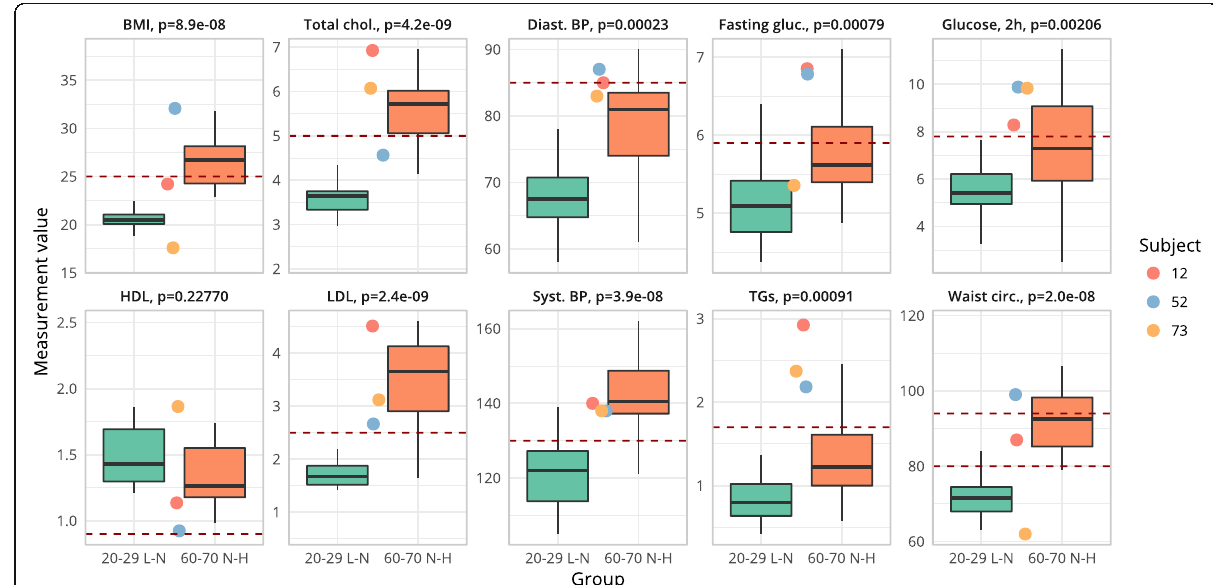
Fig. 2 Boxplots for the two reference groups “ optimal phenotypic flexibility ” (green) and “ reduced phenotypic flexibility ” (red) as well as the values of the three outlier subjects (subjects 12, 52, and 73 shown in a red, blue, and yellow circle, respectively). Box shows the 25 to 75% interquartile range; whiskers indicate the maximum and minimum non-outlier values. Crossbar indicates the median values. Horizontal dotted line indicates cut-off values; levels above this line indicate abnormal clinical values. In waist, the lower dotted line represents cut-off values for female and the upper dotted line represents cut-off values for male; p indicates statistical significance after t